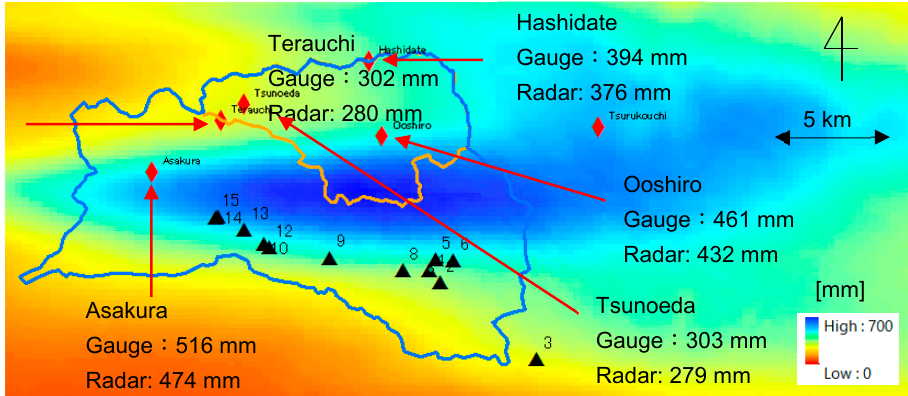
Figure 2. Cumulative rainfall distribution based on C- and X-band synthetic radar rainfall product (July 5 0:00 to July 6 0:00 in 2017). ▲ denotes the positions of our field survey for estimating the river geometry.